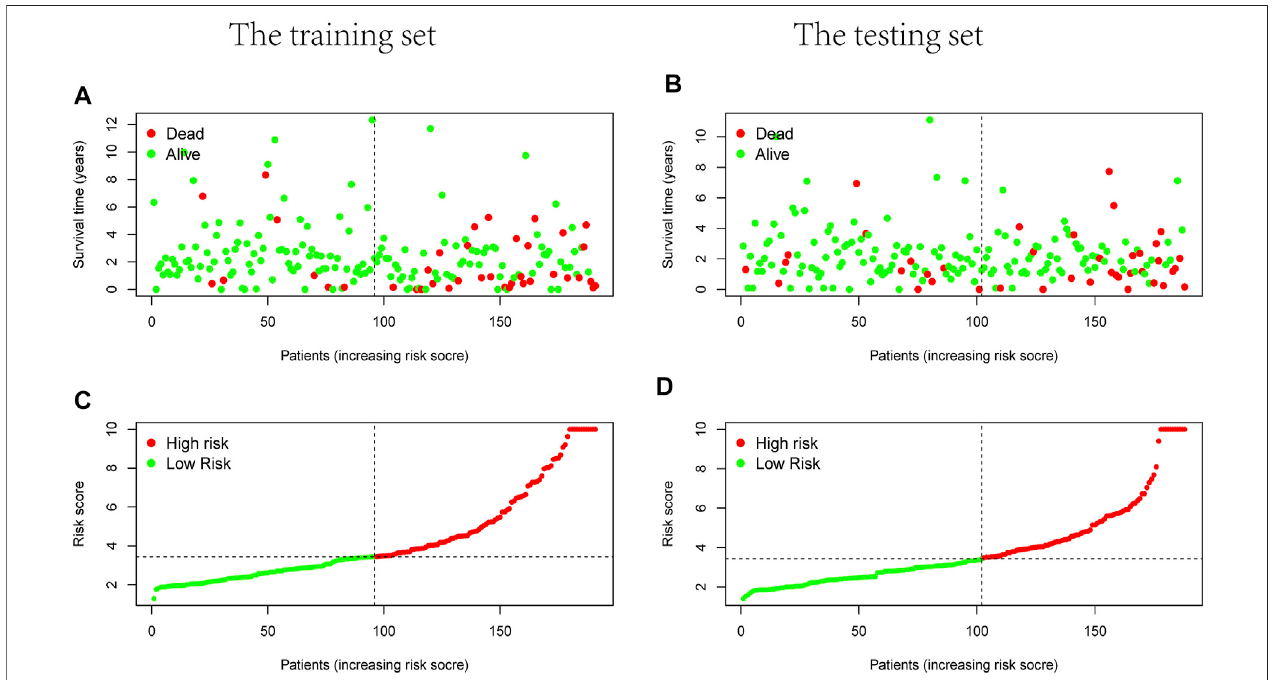
FIGURE 4 | Survival and risks state map. (A,B) Survival state of each patient, (C,D) risk state of each patient. (A,C) Training dataset, (B,D) testing dataset.